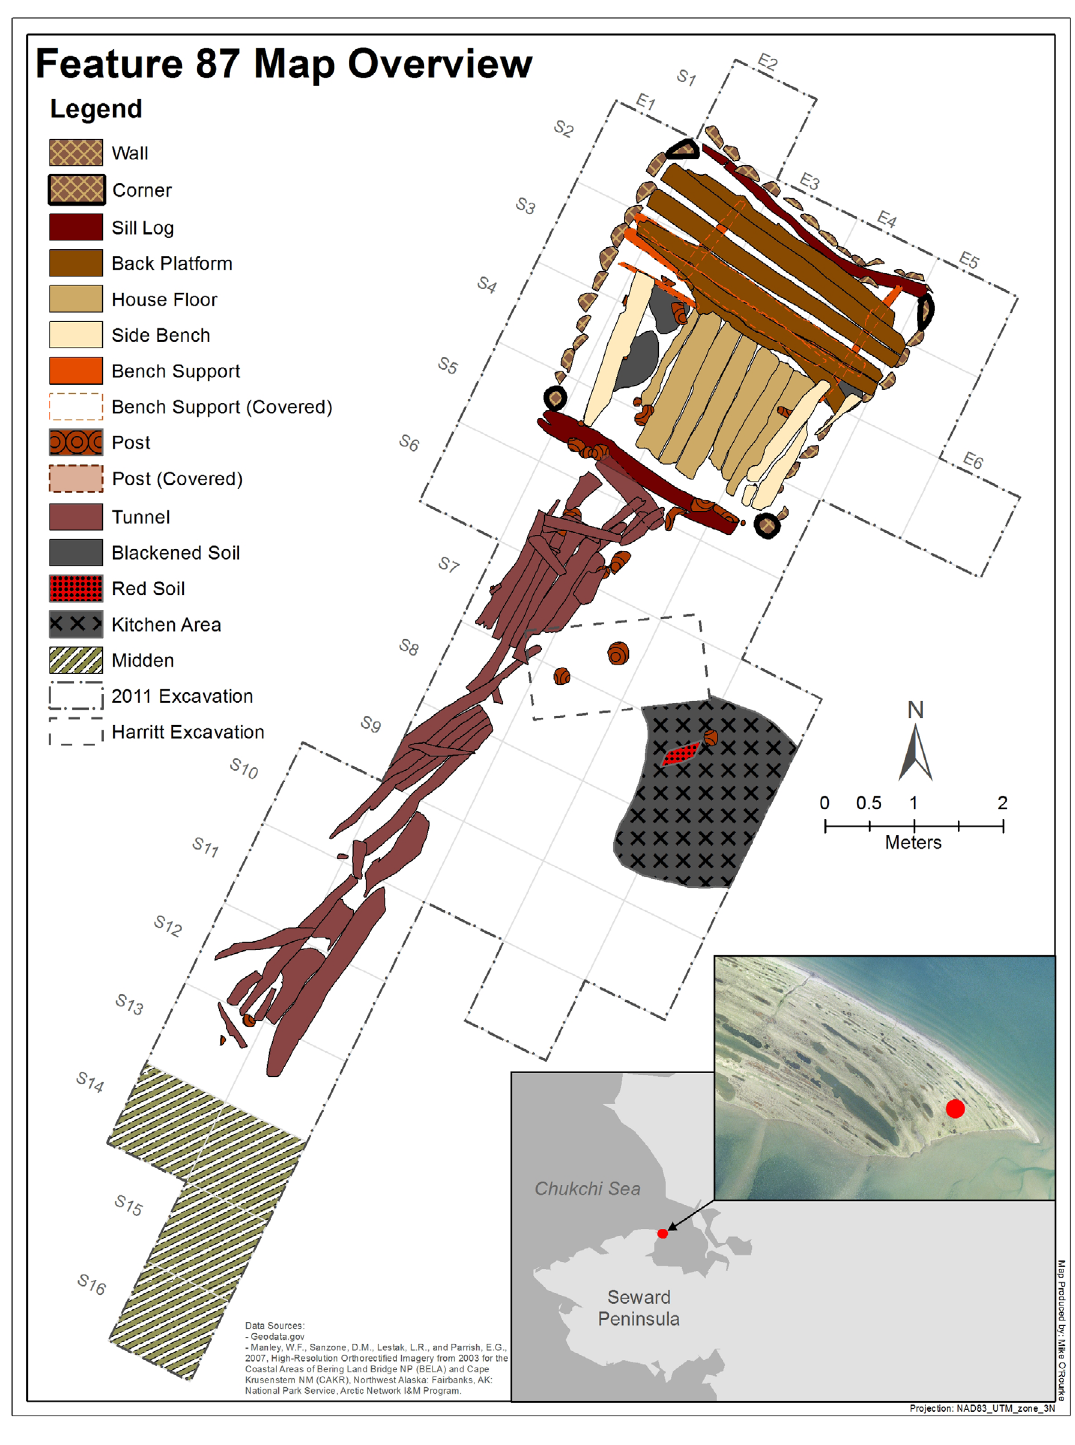
Figure 3: Feature 87 map